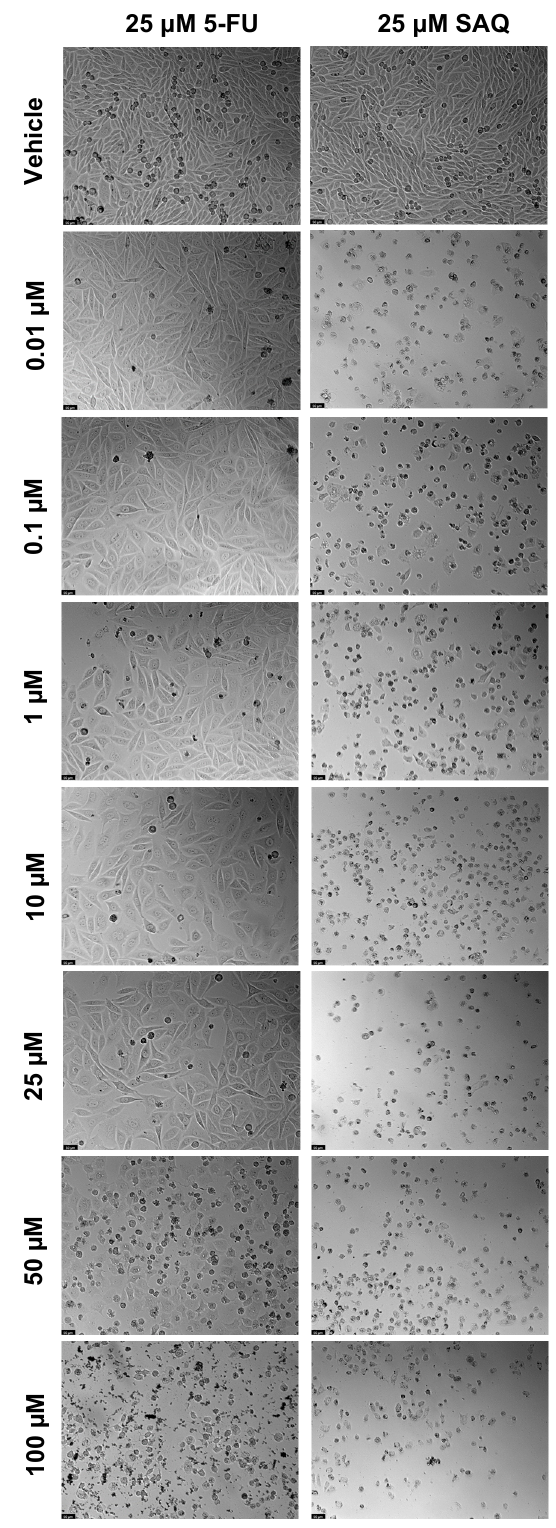
Figure 10. Morphological evaluation of PC-3 after exposure to combination of 25 μ M of 5-FU with increasing concentrations of saquinavir (0.01–100 μ M) or 25 μ M of saquinavir with increasing con- centrations of 5-FU (0.01–100 μ M) for 48 h. The second drug was only added 24 h after the first drug. Control cells were treated with the vehicle (0.01% DMSO). These images are representative of three independent experiments. The scale bar is 200 μ M.